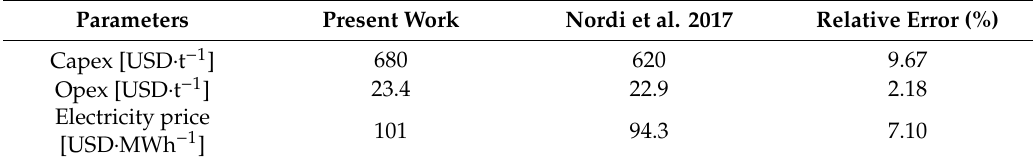
Table 2. Main parameter considered for economic validation.